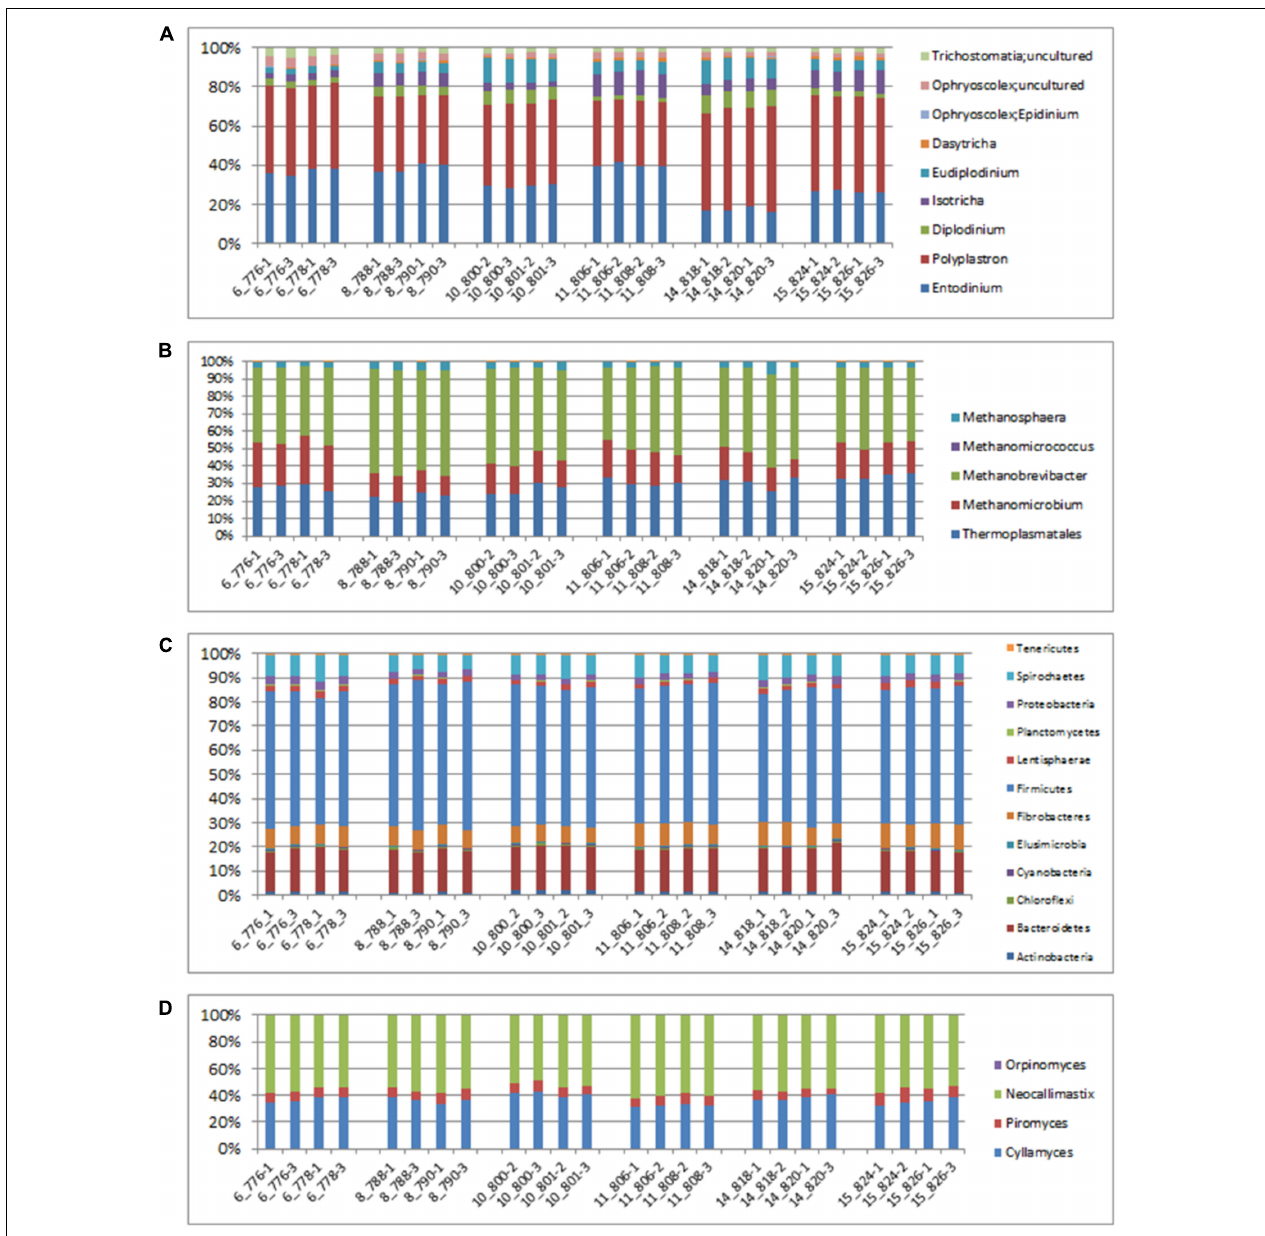
FIGURE 2 | Relative abundances of taxonomic distributions for total rRNA analysis of solid-phase rumen content of 6 cattle showing profiles for (A) Protozoa, (B) archaea, (C) bacteria and (D) fungi. The leading numbers ( y axis) refer to the animal